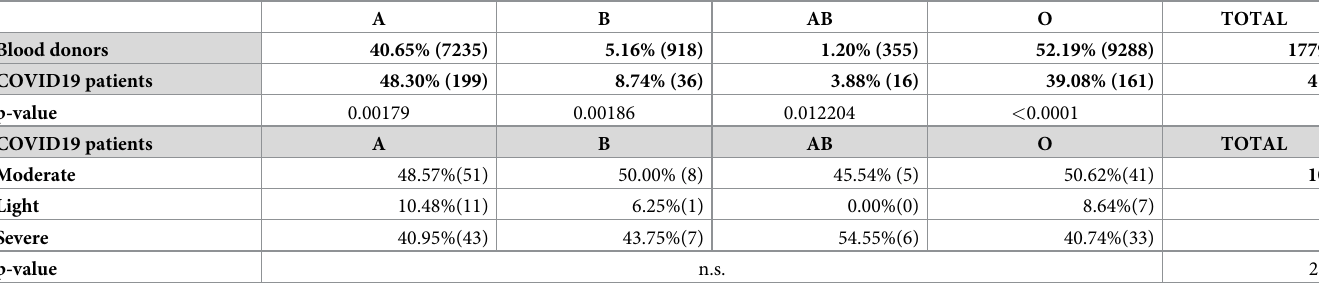
Table 1. ABO group distribution in the Gipuzkoa cohort.